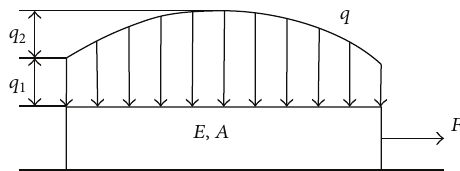
Figure 1: Microslip model for the friction interface.